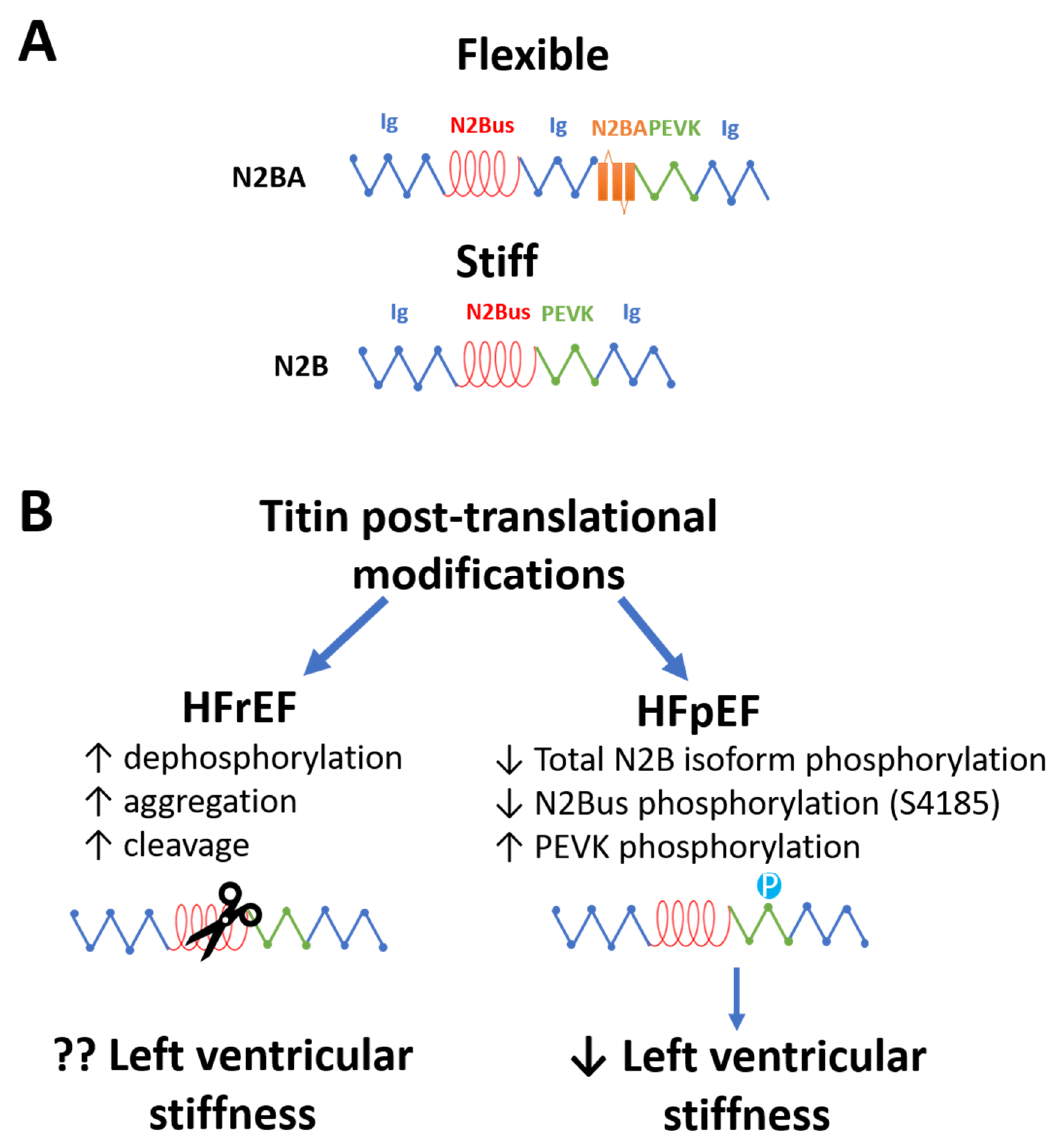
Figure 3. The role of titin in left ventricular stiffness. ( A ) Diagram of the alternative isoforms of titin. ( B ) Post-translational modifications of Titin and their effect on left ventricular stiffness in HFrEF and HFpEF.